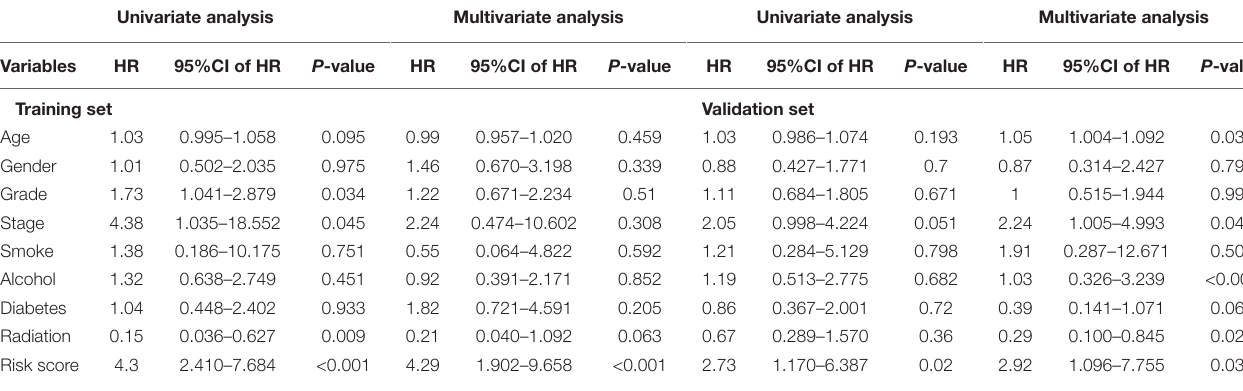
TABLE 3 | Univariate and multivariate regression analysis of pancreatic cancer patients in each data set. Univariate analysis Multivariate analysis Univariate analysis Multivariate